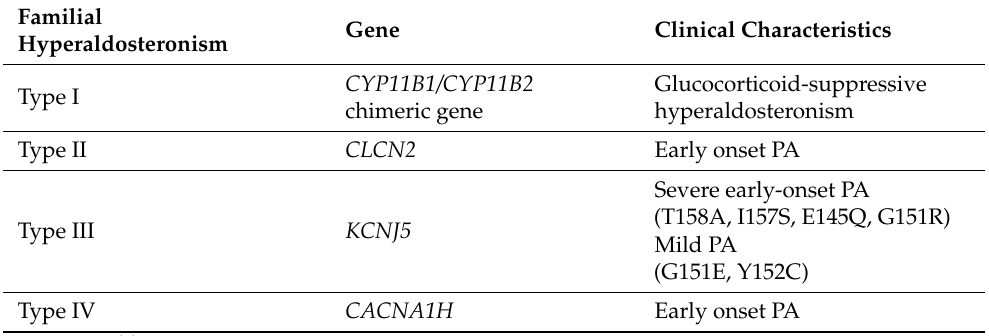
Table 1. Molecular and clinical characteristics of familial hyperaldosteronism (FH)